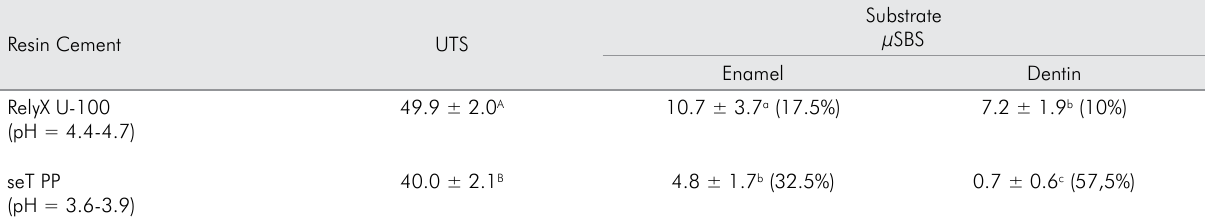
Table 2. Ultimate tensile strength (UTS), micro-shear bond strength (MPa) and pH values of the materials used in this study, and percentage of premature failures from each experimental condition